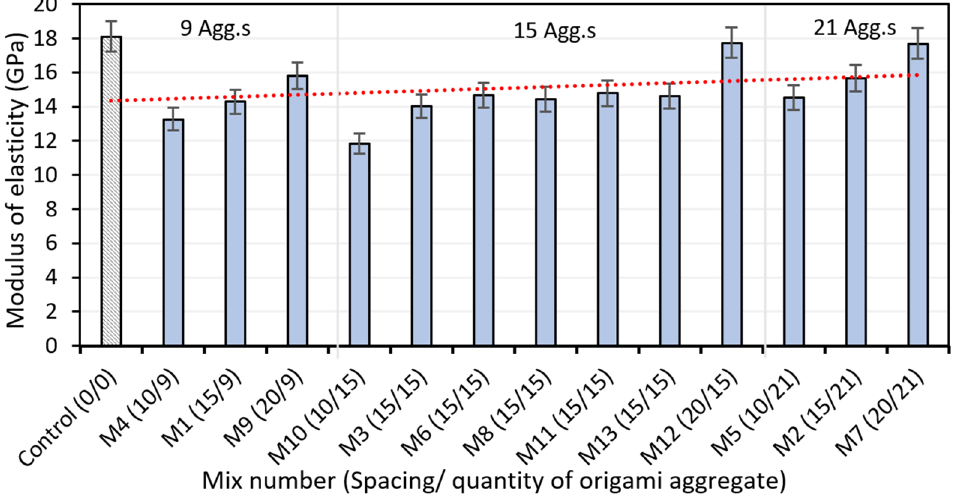
Figure 9. The modulus of elasticity of OBA ‐ RECC mixes at 28 days.